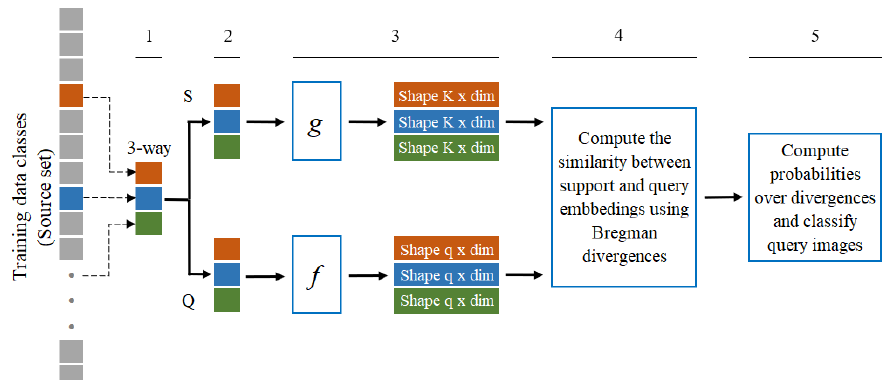
Figure 5. A generalized episode of Matching networks, where ’dim’ represents the dimension of the vectors. (1) Random selection of classes. (2) Samples division into support and query sets. (3) Full context embeddings